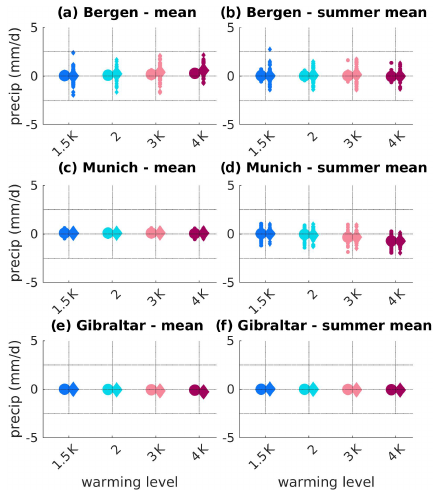
Figure 4. Annual-mean precipitation (a, c, e) and summer pre- cipitation (b, d, f) shown at each warming level relative to 1K of global warming. Shown for the GCM (circles) and the RCM (dia- monds). Each ensemble member is shown in the small symbols with the ensemble mean in the large symbol. Shown for (a–b) Bergen (60.3913 ◦ N, 5.3221 ◦ E), (c–d) Munich (48.1351 ◦ N, 11.5820 ◦ E), and (e–f) Gibraltar (36.1408 ◦ N, 5.3536 ◦ W). Each ensemble mem- bers change is computed relative to itself at